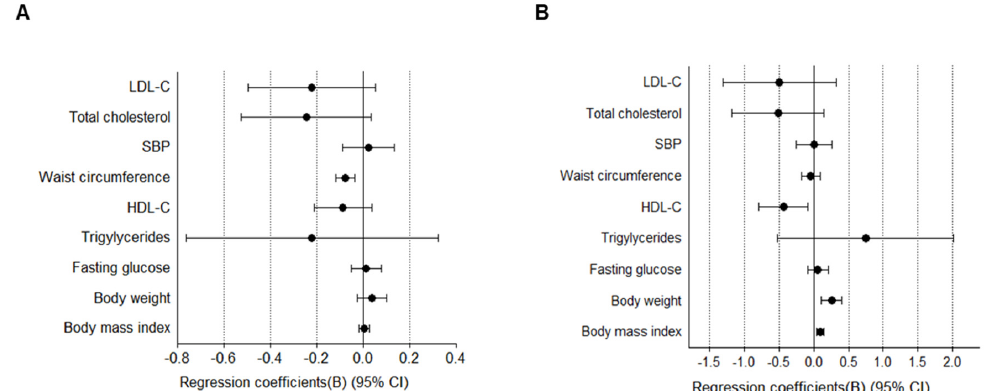
Figure 3. Associations between estradiol and cardiometabolic risk factors in post-menopausal women. ( A ) The model was adjusted for age, FSH, and body weight. ( B ) The model was adjusted for age, TSH, and body weight. Data were analyzed using multivariate regression models with each measure as the outcome and estradiol as the explanatory variable. FSH, follicle-stimulating hormone; TSH, thyroid-stimulating hormone.